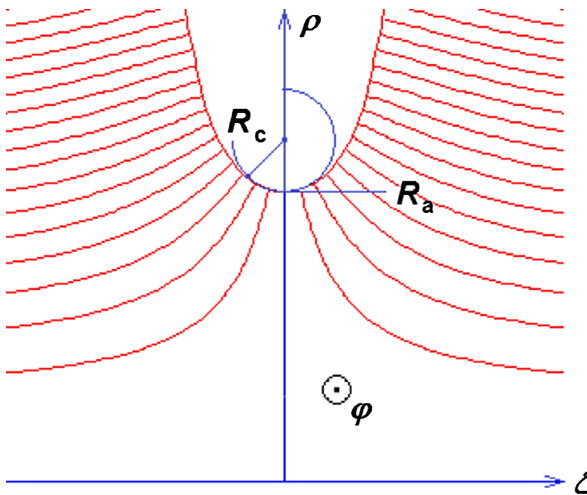
FIG. 8. Coordinate system and electric force lines near the